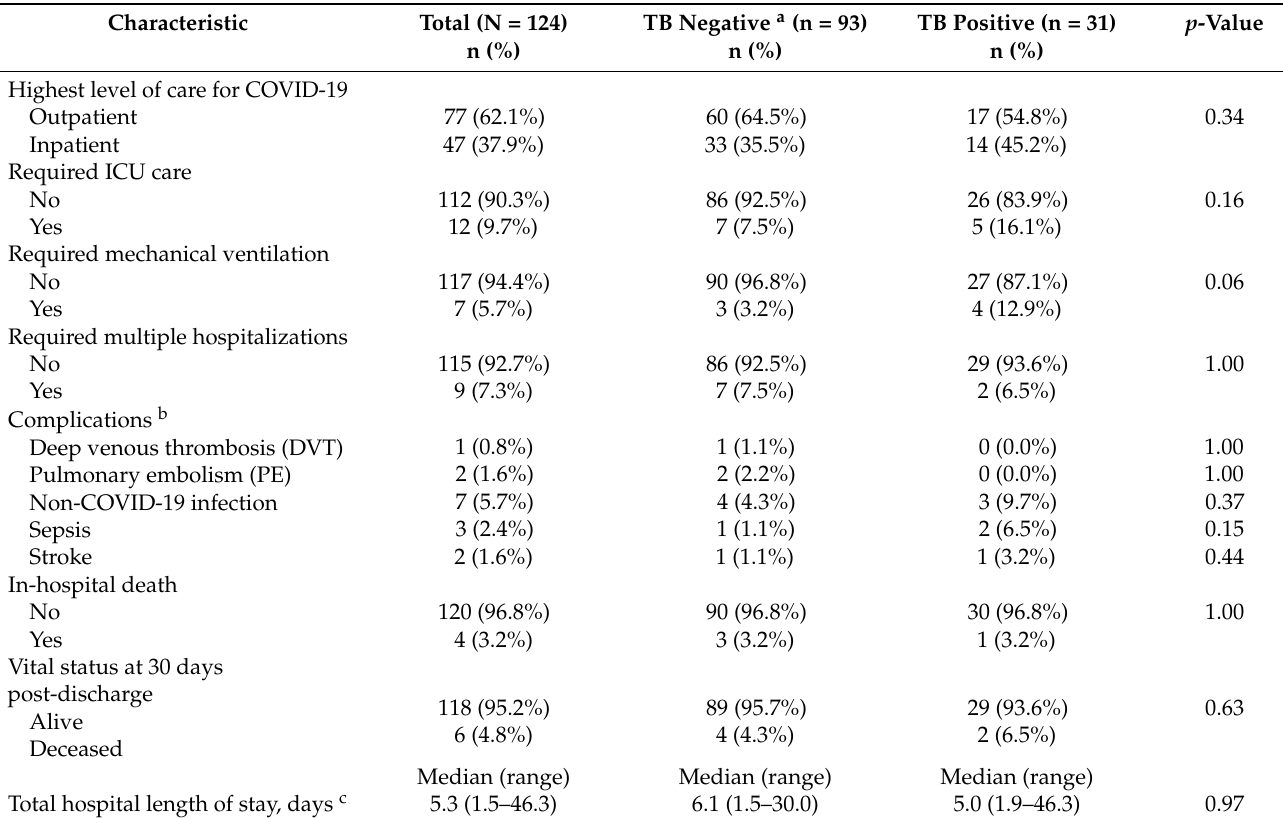
Table 2. Distribution of COVID-19 care-related characteristics and outcomes among patients with COVID-19, by tuberculosis (TB)